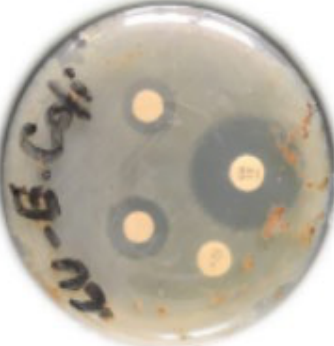
Fig. 8. Lawn culture of E. coli indicating zone of inhibition around Cu(CH